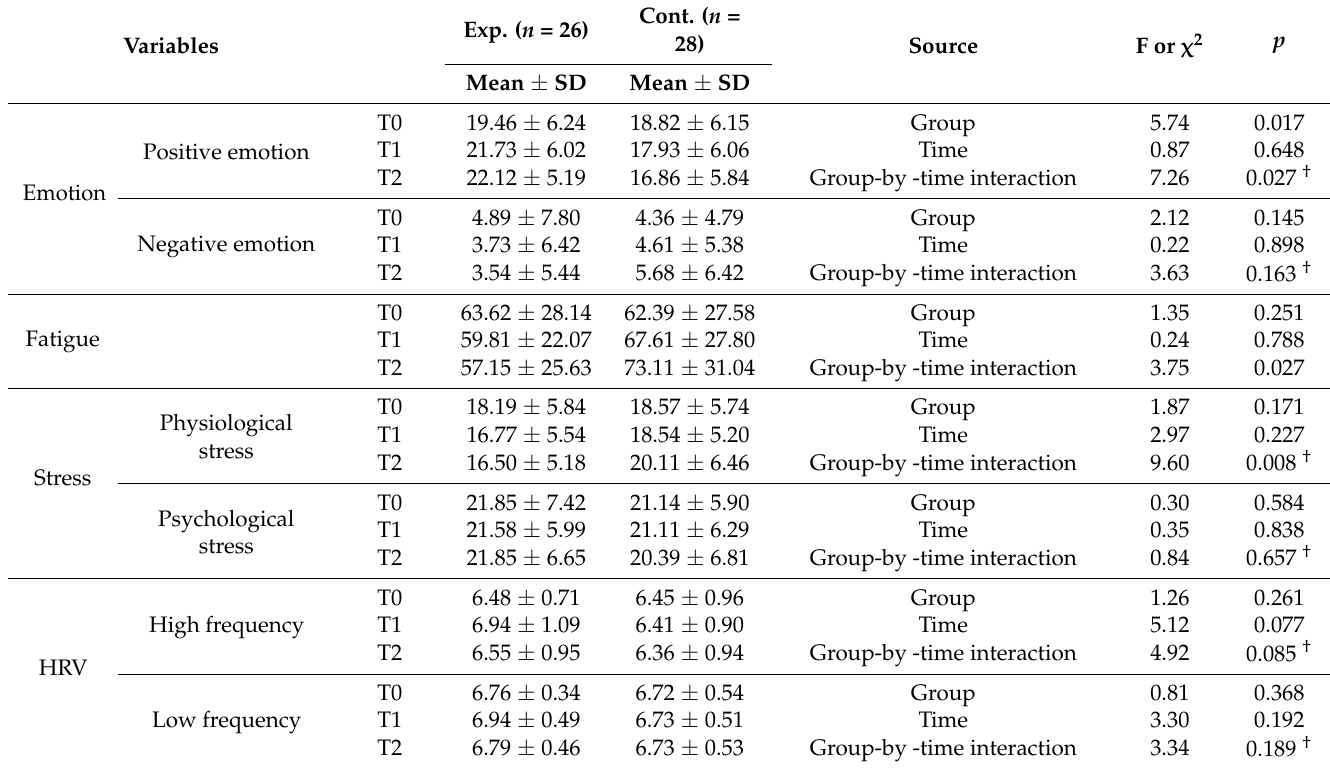
Table 5. Effect of indirect forest experience on emotion, fatigue, stress, and HRV ( n = 54).